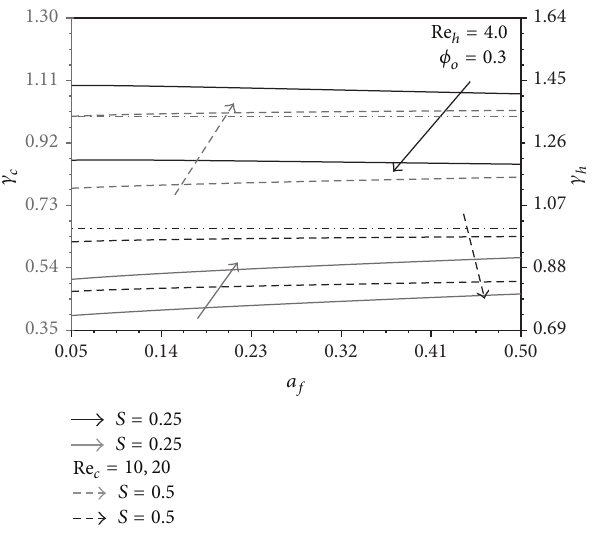
𝜀 𝜀 𝑜 and Re 𝑐 on ℎ and 𝑐 .